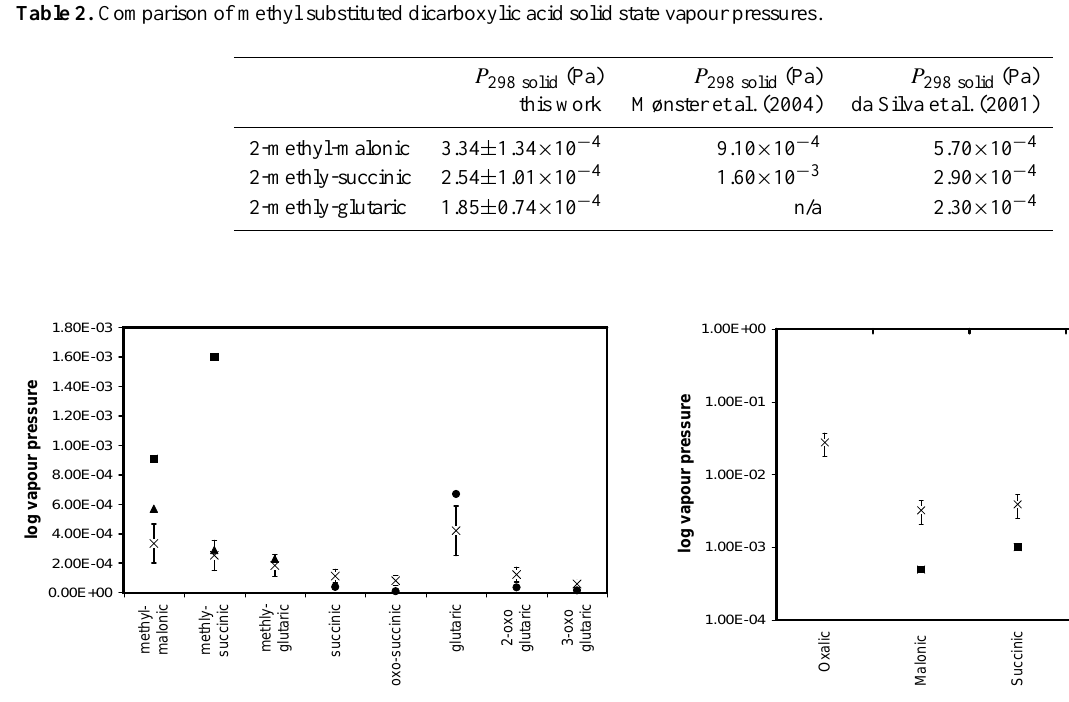
Fig. 3. Comparison of measured solid state vapour pressure at 298K in Pa with literature values. Symbols; × KEMS, N Riberio da Silva et al. (2001), l Froesch et al. (2010), (cid:4) Mønster et al. (2003). Froesch et al. (2010) suggest that 2-keto succinic and 3-keto glutaric acid may have undergone decarboxylation affecting their results. Table 3. Comparison of keto substituted dicarboxylic acid solid state vapour pressures.